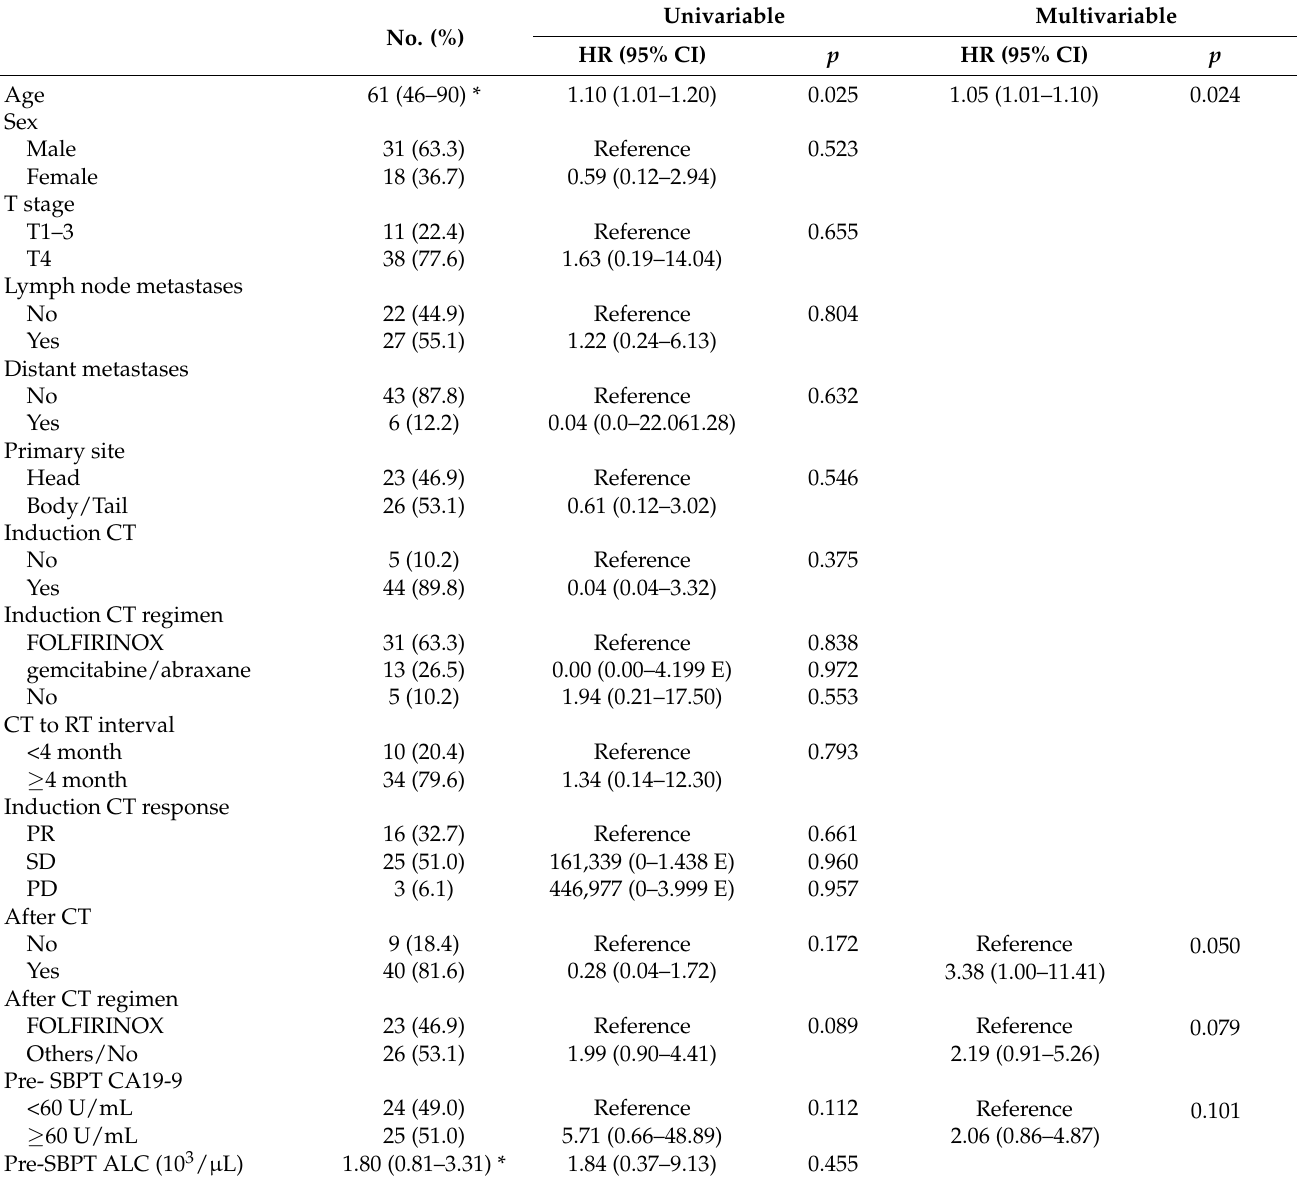
Table 2. Univariable and multivariable Cox proportional hazard model for progression-free survival ( n =